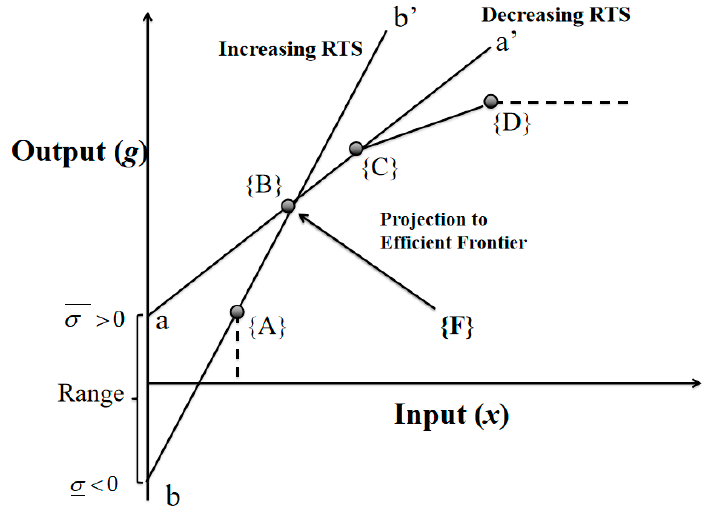
Figure 3. Upper and lower bounds of a supporting hyperplane. Note: An inefficient DMU {F} is